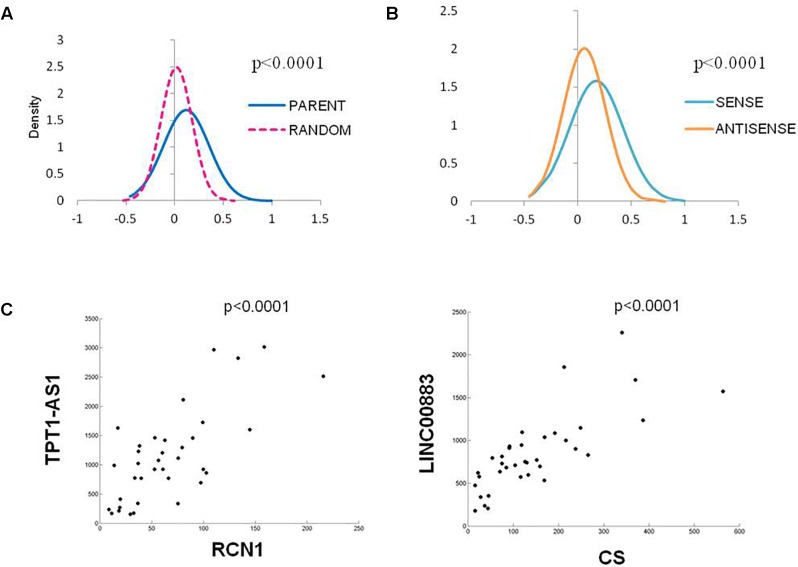
Distribution of Spearman’s Correlation rho values for all Ψ-lnc-parent-gene pairs in the TCGA dataset (n = 391). (A) Distribution of Spearman’s correlation coefficients between Ψ-lnc-parent gene pairs (blue line, median R = 0.088) and Ψ-lnc-random gene pairs (pink dashed line, median R = 0.019). Rho values of the groups were compared by Mann Whitney U-test. (B) Distribution of Spearman’s correlation coefficients between sense Ψ-lnc-parent-gene pairs (turquoise line, median R = 0.140) and antisense Ψ-lnc-parent-gene pairs (orange line, median R = 0.049). (C) Correlation scatter plots of Ψ-lncs with positive expression correlations to cancer-associated parent genes.